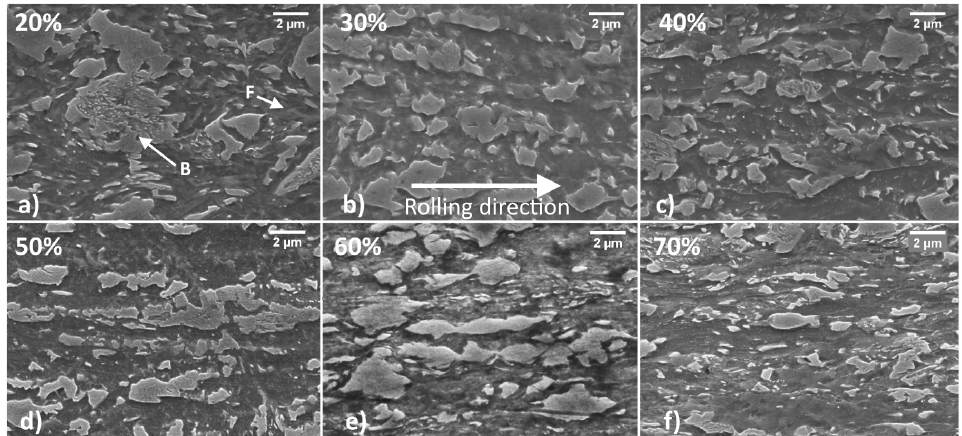
Figure 2. Microstructures of the DP steel as the thinning level is increased, samples with longitu- dinal orientation observed with SEM. Thinning level is increased as follows 20, 30, 40, 50, 60, 70% represented in ( a ), ( b ), ( c ), ( d ), ( e ) and ( f ) panels.